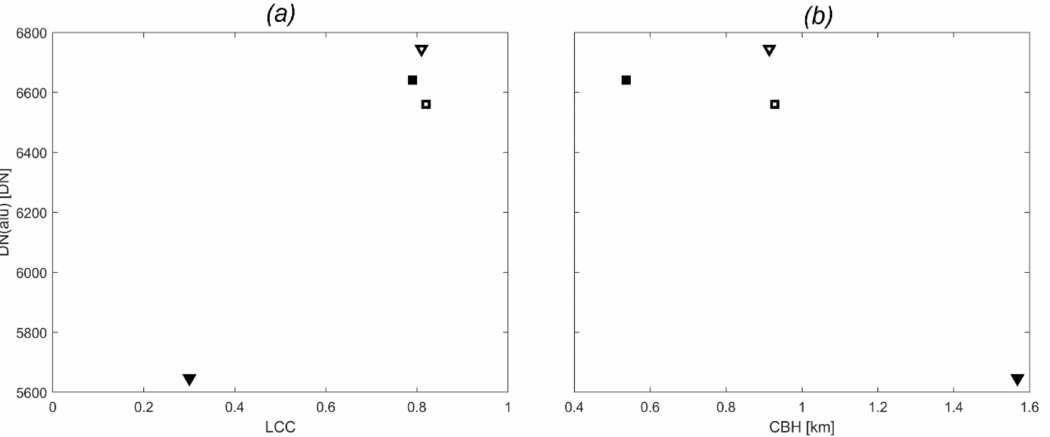
Figure 6. Scatter plots of DN(alu) from images after flatfield correction with sigma = 30, as a function of ( a ) LCC, and ( b ) CBH; black squares/triangles indicate April/August field surveys with open/filled symbols representing